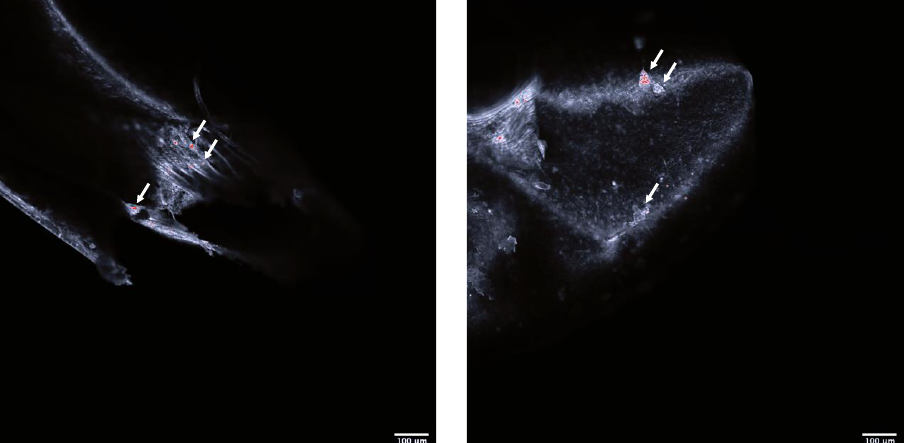
Figure 1. Head ( left ) and body ( right ) of Neocardina heteropoda. White arrows are pointing to overexposed structures considered to be polystyrene nanoparticles. Scale bar 1000 μm. Red dots are overexposed structure of Neocardina heteropoda.